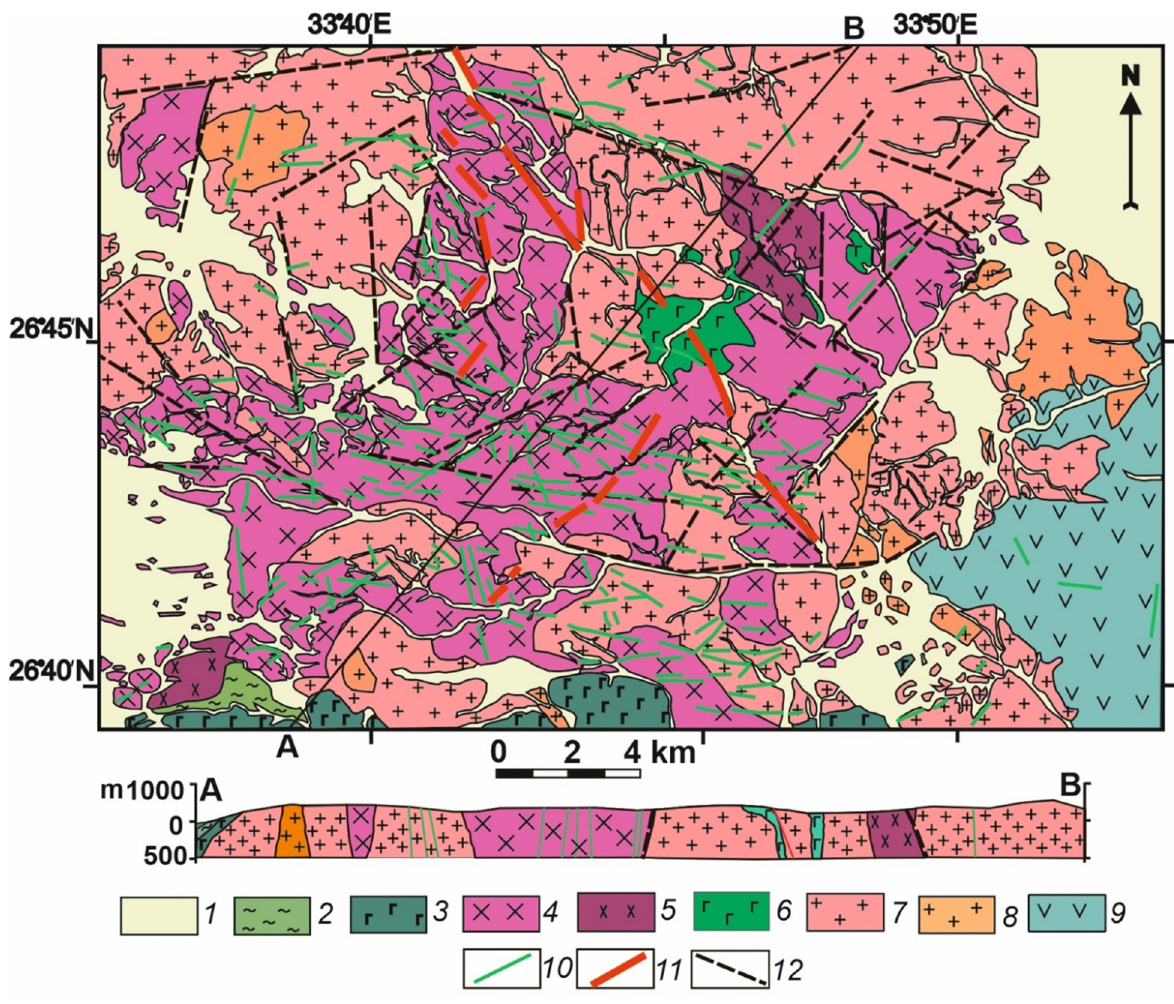
Figure 2: Geological map of Um Taghir area, created based on integrated processing of data from regional geological surveys, remote sensing, and fi eld observations. Quaternary formations: 1 – ( sand, pebbles, conglomerates ) . Neoproterozoic formations: 2 – schist; 3 – metagabbro; 4 – granodiorite; 5 – tonalite; 6 – gabbro; 7 – monzogranite, 8 – alkali - feldspar granite; 9 – Dokhan volcanics; ( 10 ) ma fi c dikes; 11 – felsic dikes; 12 –